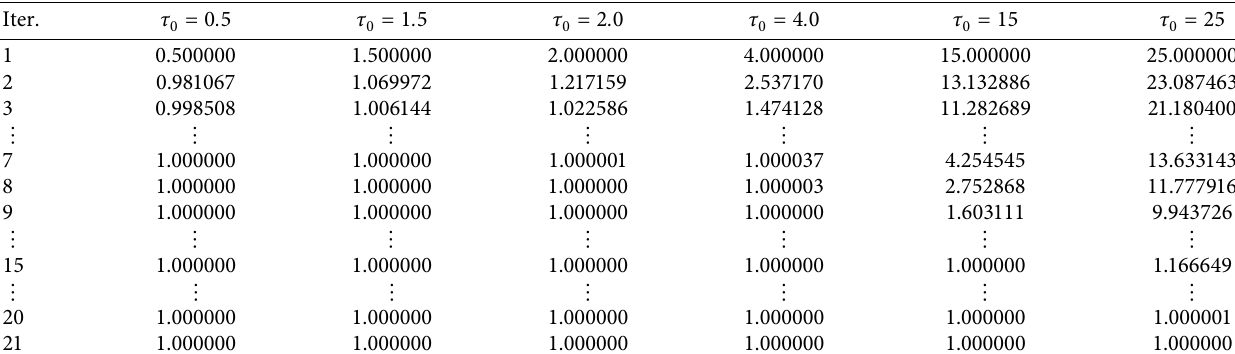
Table 3: A comparison table for the speed of convergence of iterative method (8) for diferent initial points.